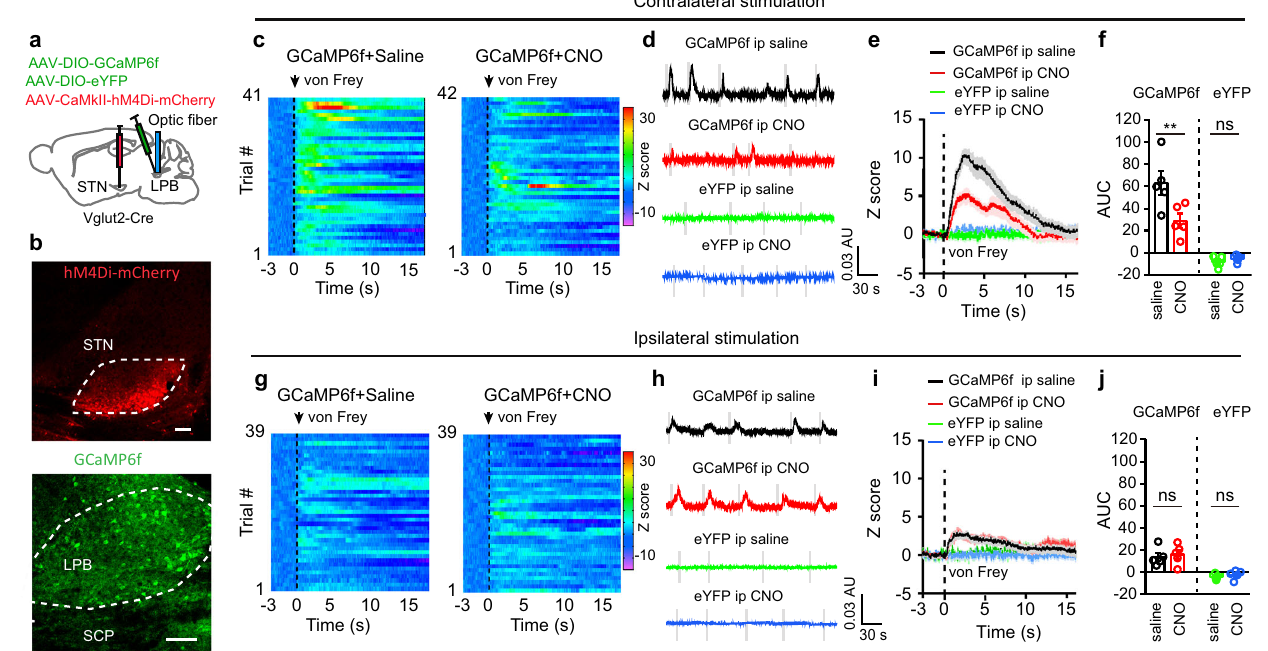
Fig. 5 | Chemogenetic silencing of STN neurons reduces the response of LPB Glu neurons to peripheral mechanical stimulation. a Experimental approach for GCaMP6 signal recordings of LPB Glu neurons with chemogenetic inhibition of STN neurons. b Example images of hM4Di and GCaMP6f expression in the injection sites. c – j Heat maps ( c , g ), example traces ( d , h ), average traces ( e , i ), and quanti- fi cation ( f , j , AUC in panels e and i ) of GCaMP6f signal in the LPB of mice receiving